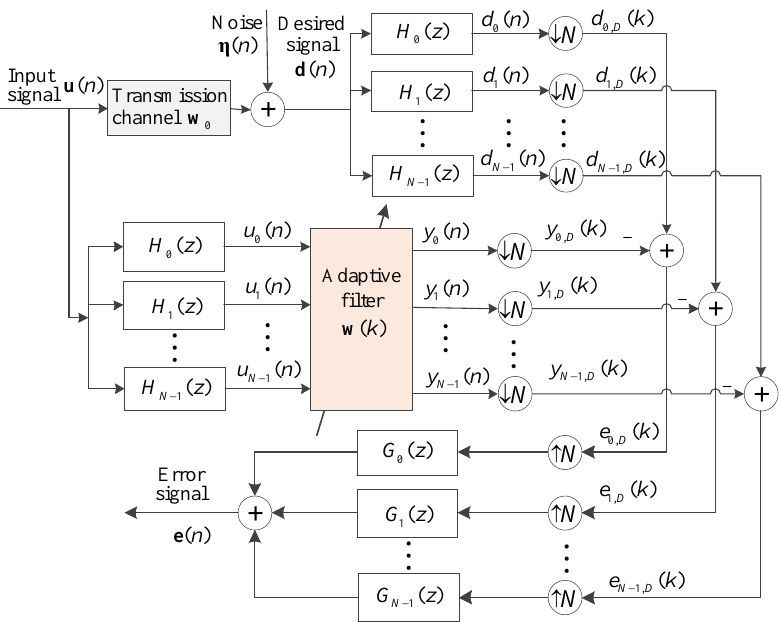
Figure 1. The structure of normalized sub-band adaptive filtering (NSAF). Subsequently, u ( n ) , d ( n ) , and η ( n ) are divided into N sub-band signals by the fil- ters H 0 ( z ) , H 1 ( z ) , ..., H N − 1 ( z ) , respectively. u i ( n ) , d i ( n ) , and η i ( n ) are the corresponding sub-band signals, i = 0, 1, ..., N − 1. The sub-band signals y i ( n ) and d i ( n ) are critically decimated to generate the signals y i , D ( k ) and d i , D ( k ) , respectively. y i , D ( k ) = u T is the output of the i th sub-band filter. In each of the above equations, n indicates the sequence number of the original signal, and k indicates the sequence number of the deci- mated sequences. Therefore, the input signal, the desired output signal, and the output error can be represented